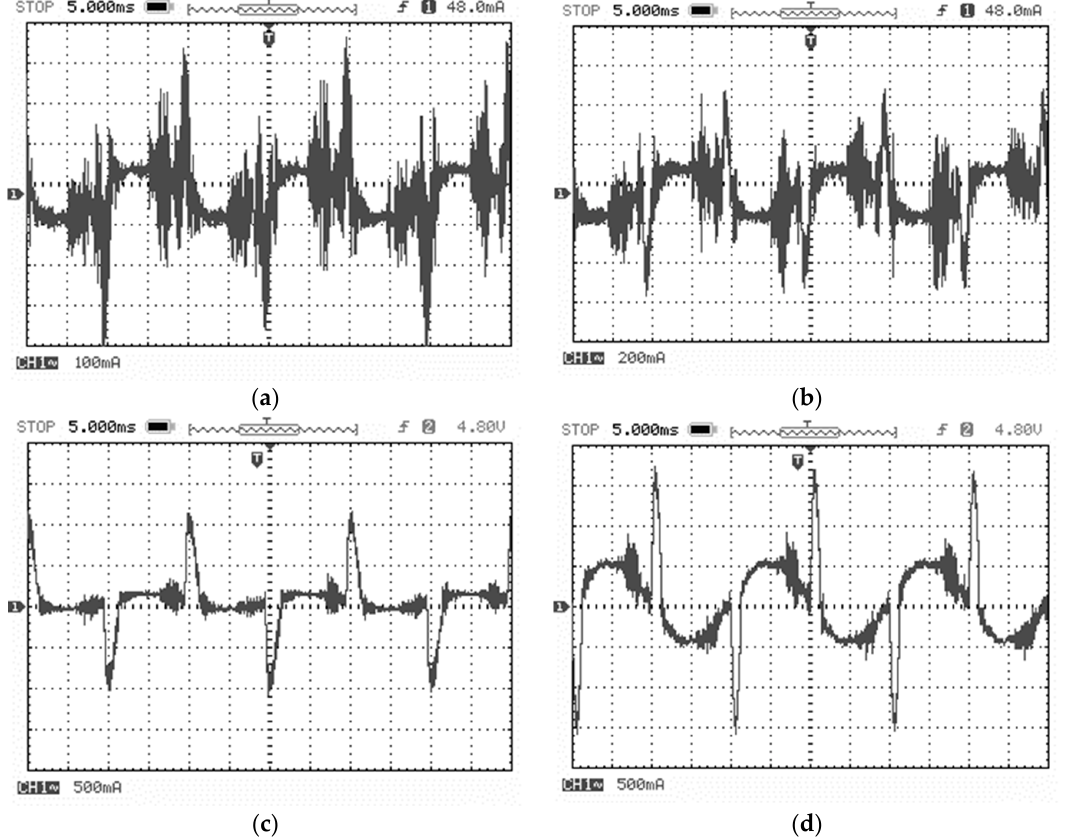
Figure 6. Experimental waveform for case of LED lamp and driver with brand B. ( a ) Current waveform in the case of one lamp with one driver; ( b ) Current waveform in the case of two lamps with two drivers; ( c ) Current waveform in the case of eight lamps with one driver; ( d ) Current waveform in the case of eight lamps with eight drivers.